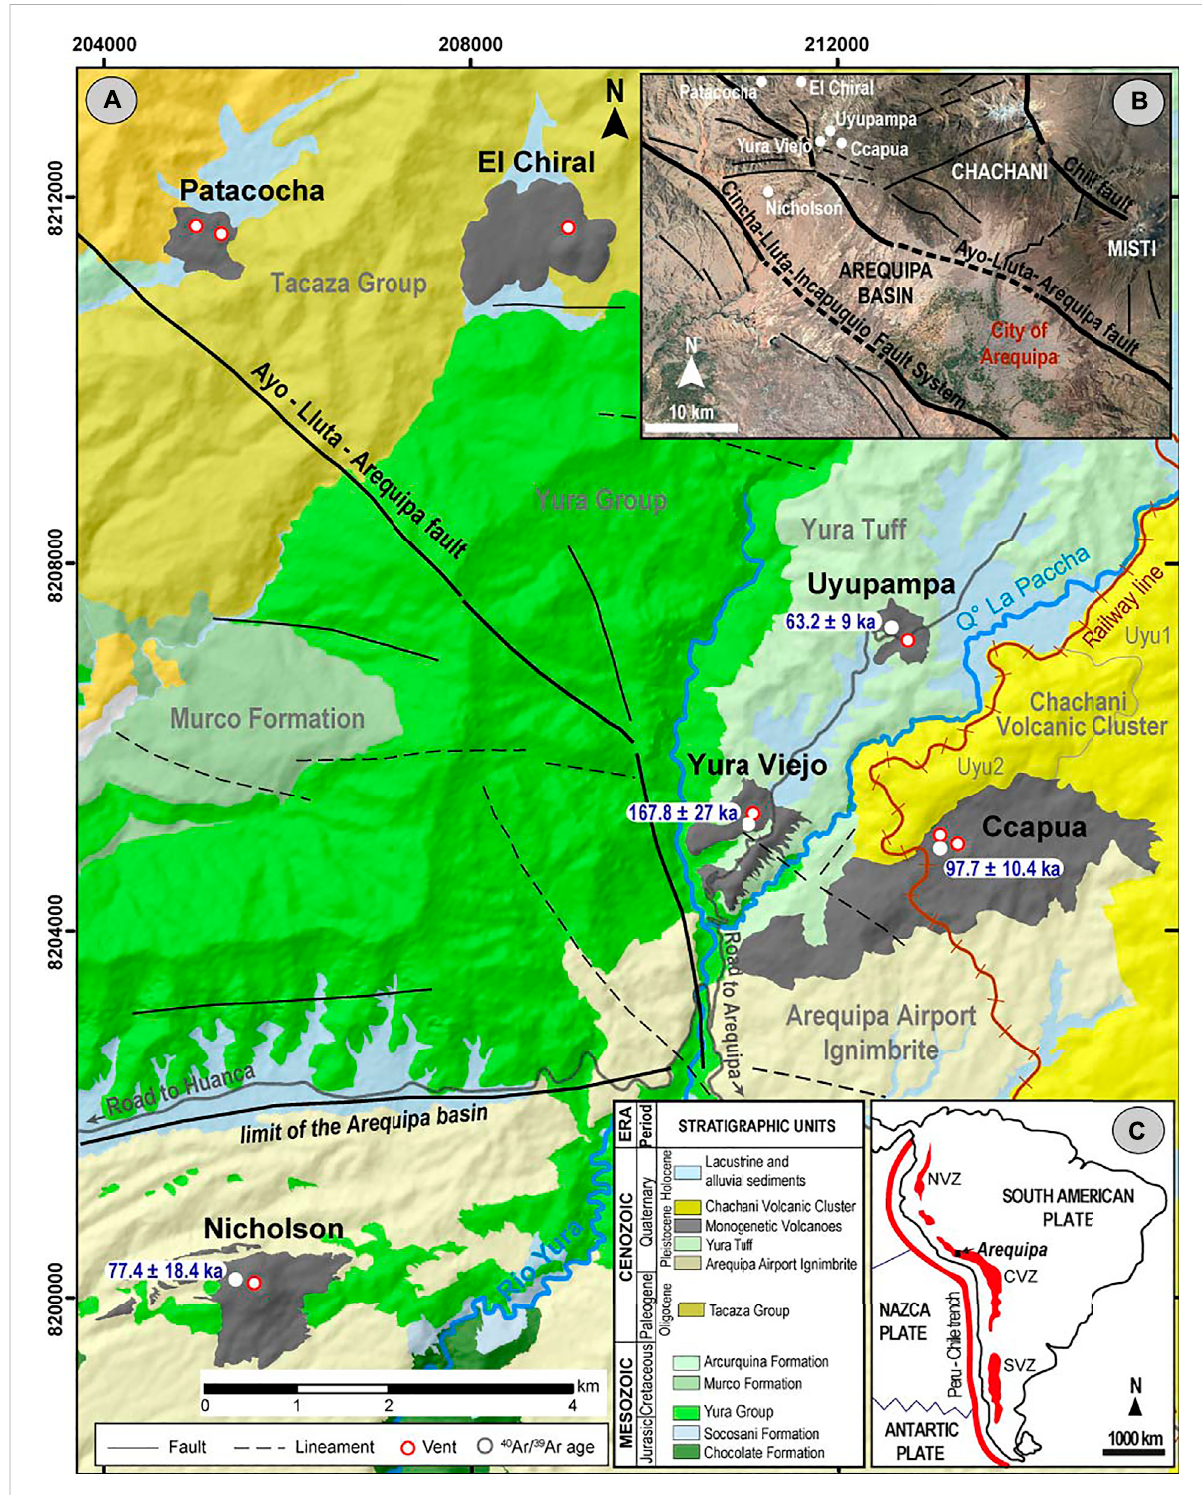
FIGURE 1 (A) Geological map of the Yura Monogenetic Field, northeastern of the Arequipa basin. Lithological data was taken from GEOCATMIN, INGEMMET(2014) and Paquereau-Lebti et al. (2006). Relief of image taken from Arc Map World Imagery Service. (B) Inset of aschematic map of the structural setting of the Arequipa basin and surrounding areas. (C) Inset of the subduction zone and convergence between Nazca and South American plates are indicated. Red polygons indicate the Northern (NVZ), Central (CVZ) and Southern (SVZ) Volcanic Zones respectively. Continuous and thick red line indicates the Peru-Chile